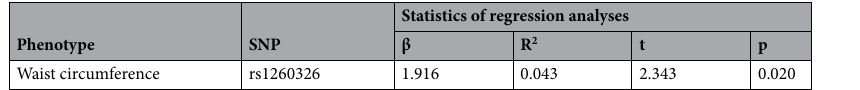
Table 5. Logistic regression analysis on the impacts of GCKR rs1260326 on waist circumference after the adjustment of gender and age. The T/T genotype was used as reference. GCKR glucokinase regulator, SNP single nucleotide